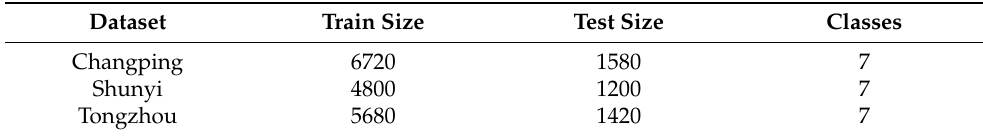
Table 1. Datasets used for image classification